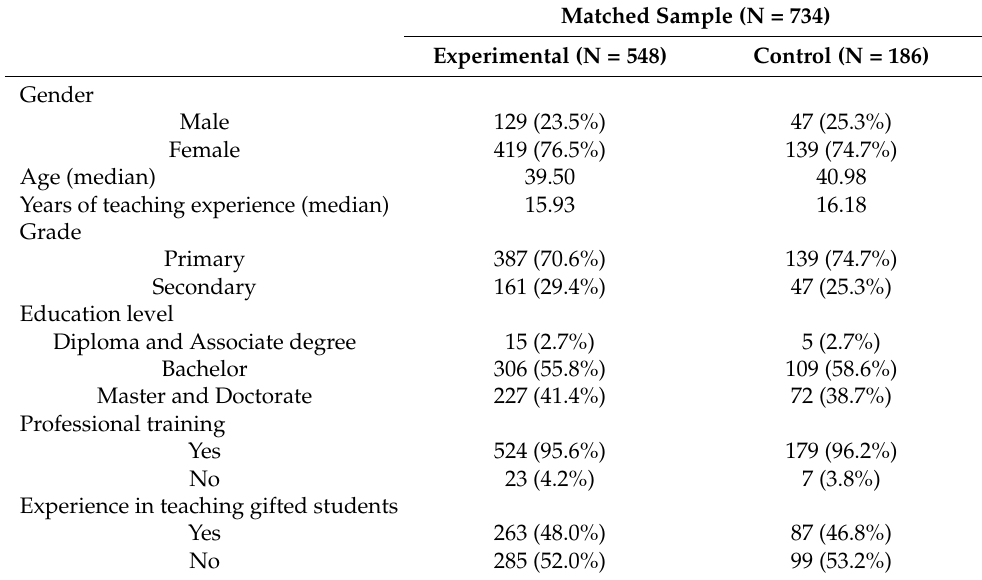
Table 2. Demographic information of the